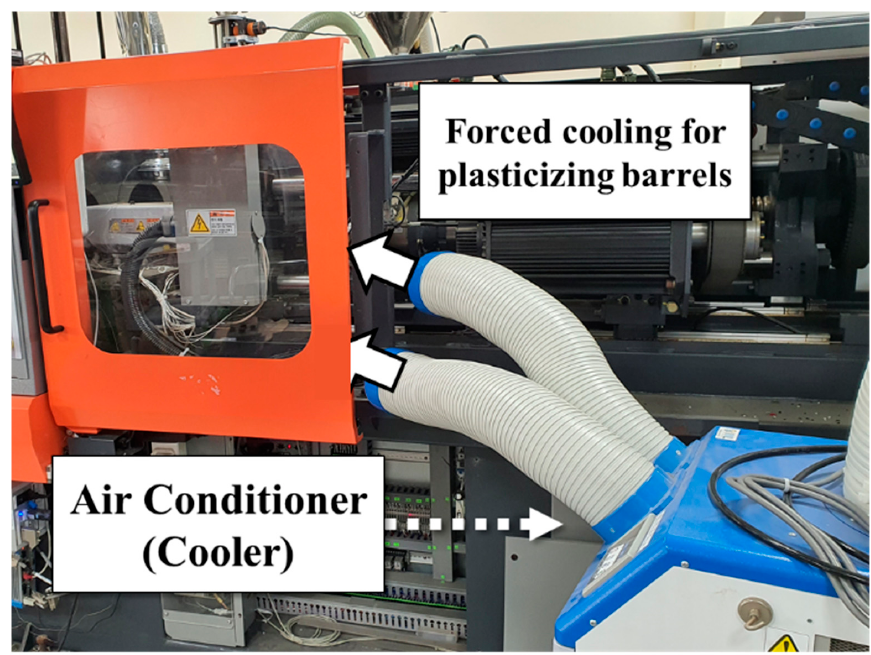
Figure 6. Forced cooling of the plasticizing barrel using a cooler; the input energy of the heater varies significantly. Table 1. Experimental conditions using HDPE.